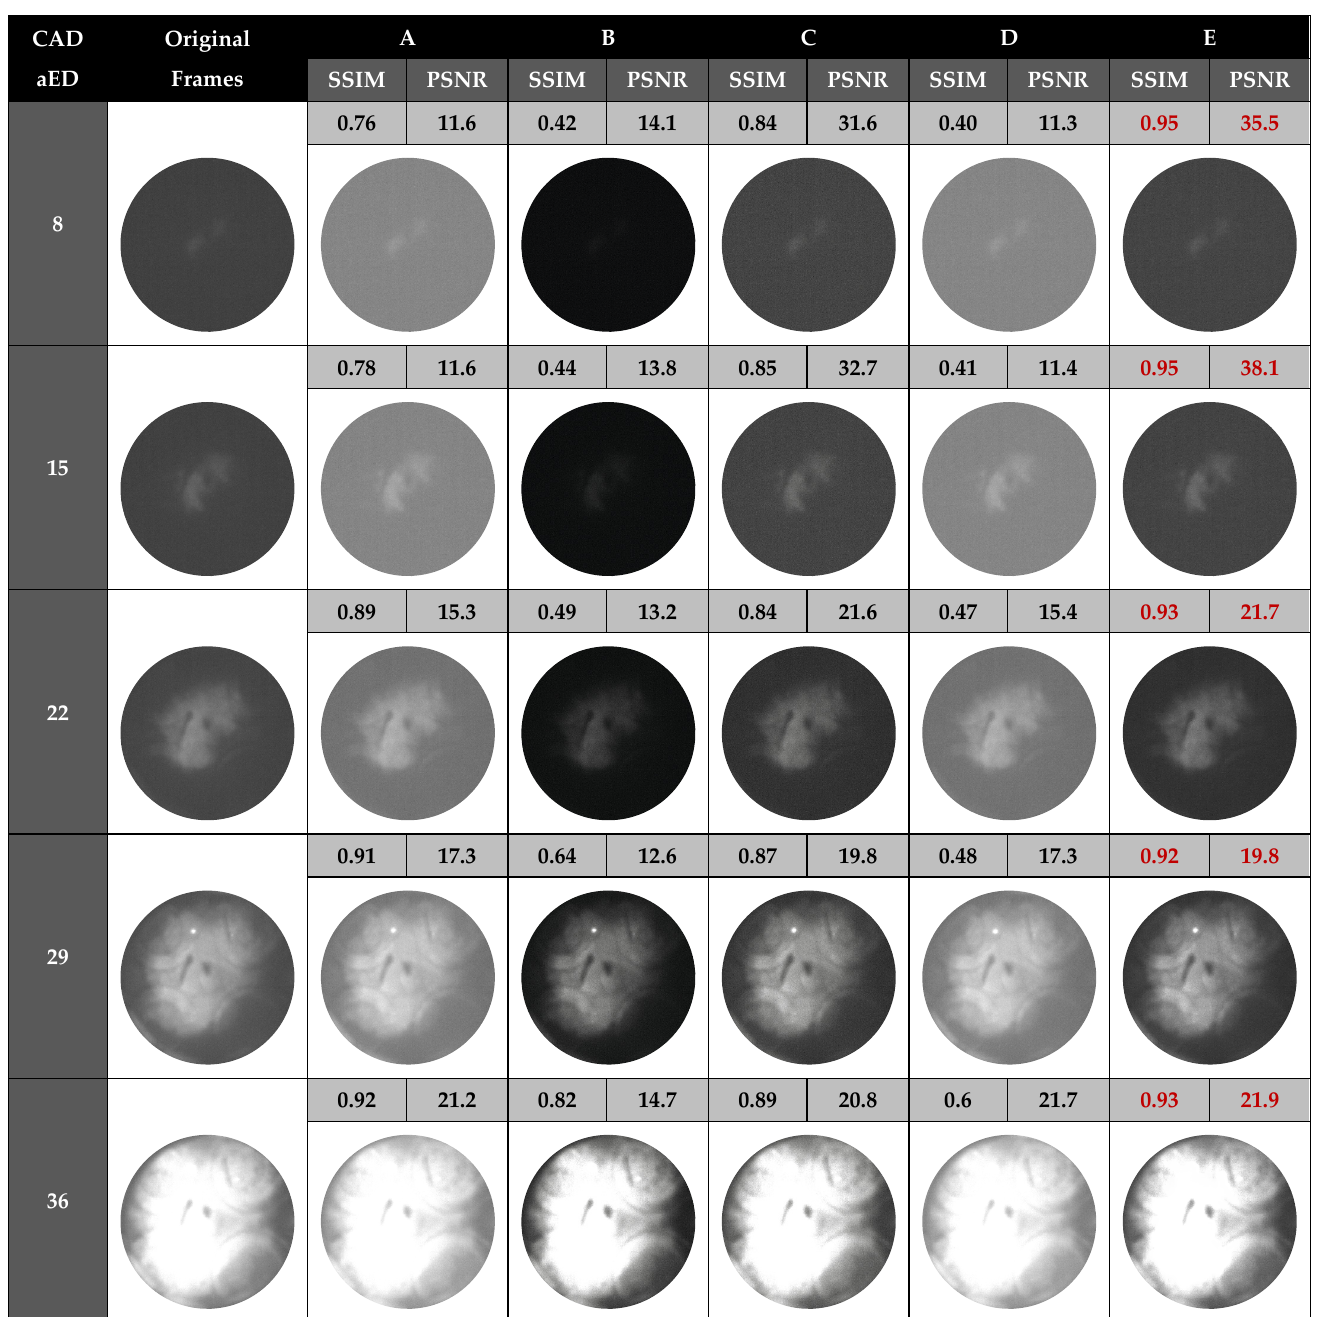
Table 3. Outputs of the algorithms reported in Table 2, at each specific CAD aED. PSNRs and SSIMs are computed as the average value of 63 values (equal to the number of consecutive recorded combustion events).